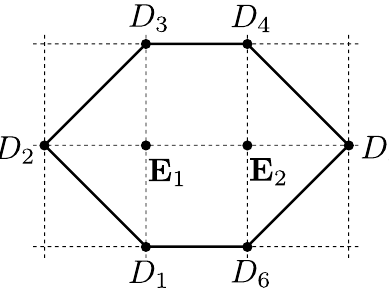
Figure 16: The toric diagram of the beetle